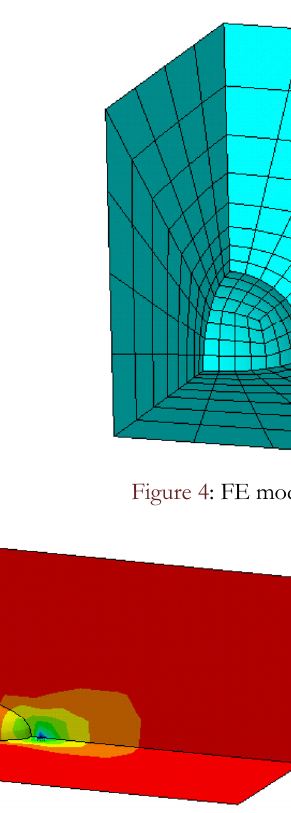
Figure 5: Strain (  x ) distribution for the two load